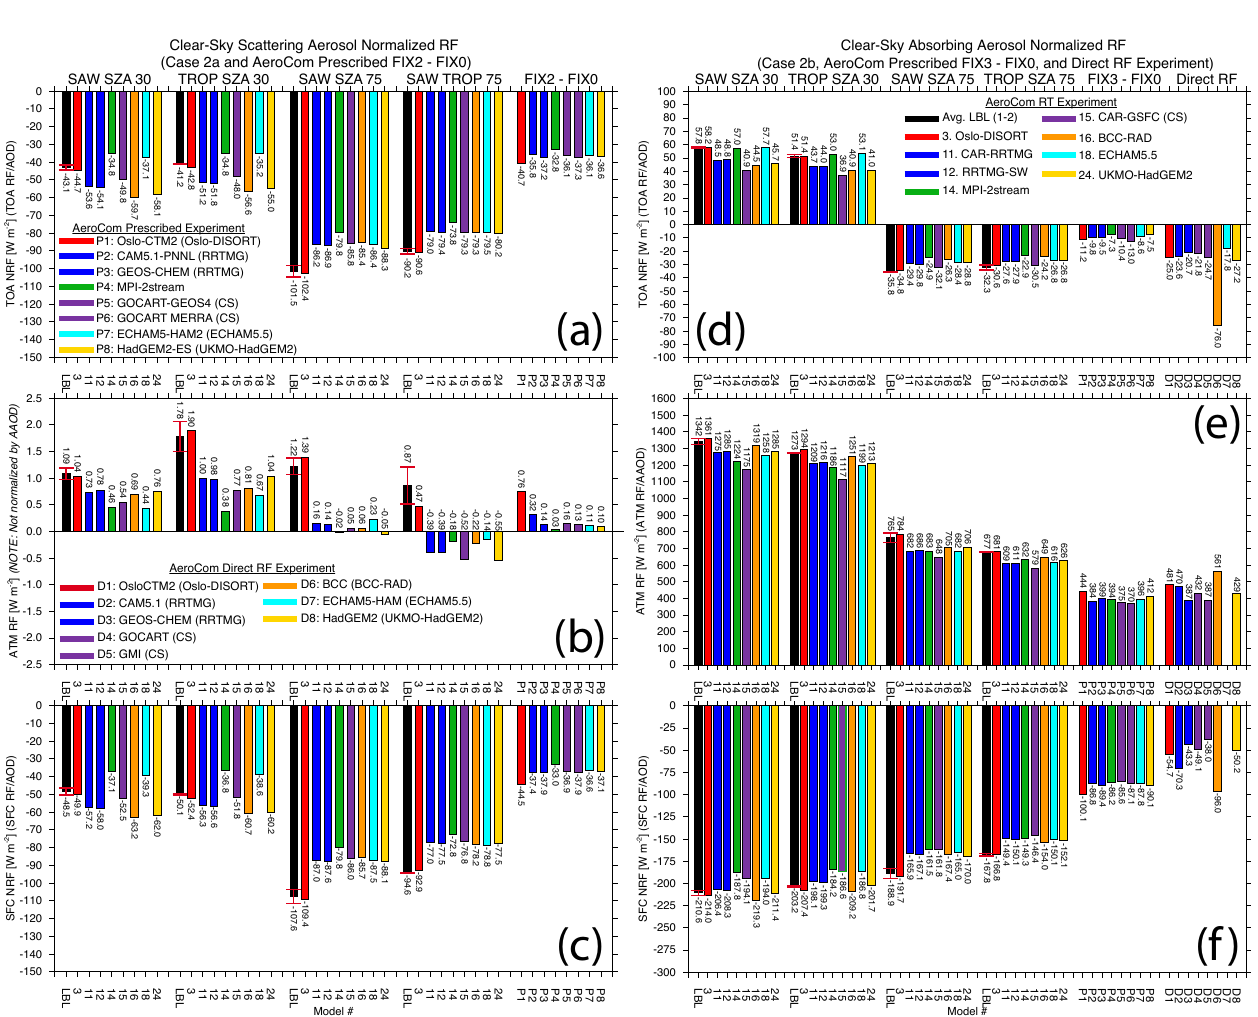
Fig. 8. Summary of clear-sky (cloud-free) aerosol direct normalized radiative forcing (NRF) from the present study (AeroCom Radiative Transfer Experiment), the AeroCom Prescribed Experiment (Stier et el., 2012), and the AeroCom Direct Radiative Forcing Experiment (Myhre et al., 2013). NRF is defined as the TOA and SFC RF divided by the AOD and the ATM RF divided by the absorption optical depth (AAOD = (1 − SSA) × AOD). Results from Stier et el. (2012) and Myhre et al. (2013) are from Table 3 of each study. Models which use similar radiative transfer schemes have the same color bar. (a) Comparison of TOA NRF results from Case 2a (Scattering Aerosols) versus the FIX2–FIX0 (Stier et el., 2012); aerosol properties in these two studies are identical (AOD = 0.2, SSA = 1.0) except in Stier et el. (2012) host models simulate their own surface albedo and gaseous absorbers. Also, the results for FIX2–FIX0 are global and diurnal average results. (b) Comparison of ATM RF results from Case 2a (Scattering Aerosols) versus FIX2–FIX0. Note: We do not show normalized atmospheric radiative forcing because the AAOD is zero in the scattering aerosol case. Non-zero ATM RF in the scattering case results from enhanced molecular absorption due to aerosol scattering as described in the text. (c) Comparison of SFC NRF from Case 2a and FIX2-FIX0. (d–f) Comparison of TOA, ATM, and SFC NRF results from Case 2b (Absorbing Aerosols) versus the global average result from FIX3-FIX0 (Stier et el., 2012), which also has the same specified aerosol optical properties (but not the same albedo or gaseous absorbers; AOD = 0.2, AAOD = 0.04). We also include results from the AeroCom Direct Radiative Forcing Experiment (Myhre et al., 2013). Note that in the global and diurnally averaged results in Myhre et al. (2013), models are run in their standard configuration, simulating all included aerosol processes. The mean SSA for the eight models here was 0.941 with a standard deviation of 0.02, and the mean global AOD was 0.0245 with a standard deviation of 0.008 (Table 3; Myhre et al.,